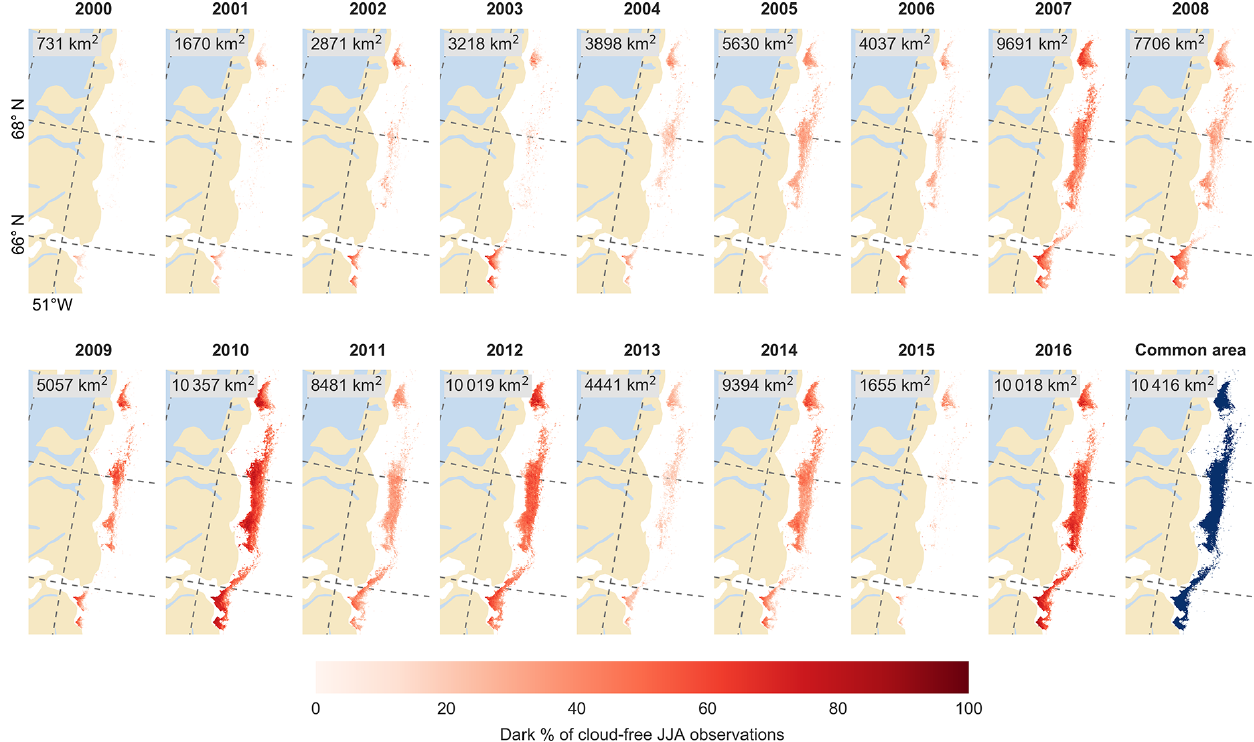
Figure 1. D D on the south-west GrIS each summer from 2000 to 2016, expressed as a percentage of the total daily cloud-free observations made during June–July–August (JJA). Each year is labelled with D E . In each year, pixels that are dark for fewer than 5 days are not shown. Bottom-right panel: common area of dark ice used for interannual